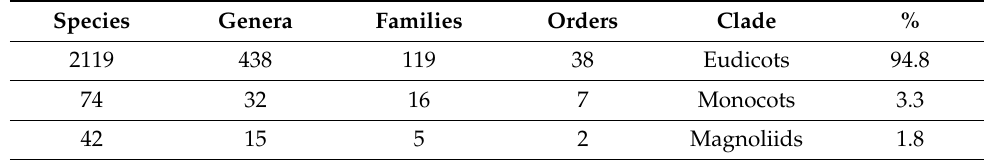
Table 1. Classification of all EFFs of the world.